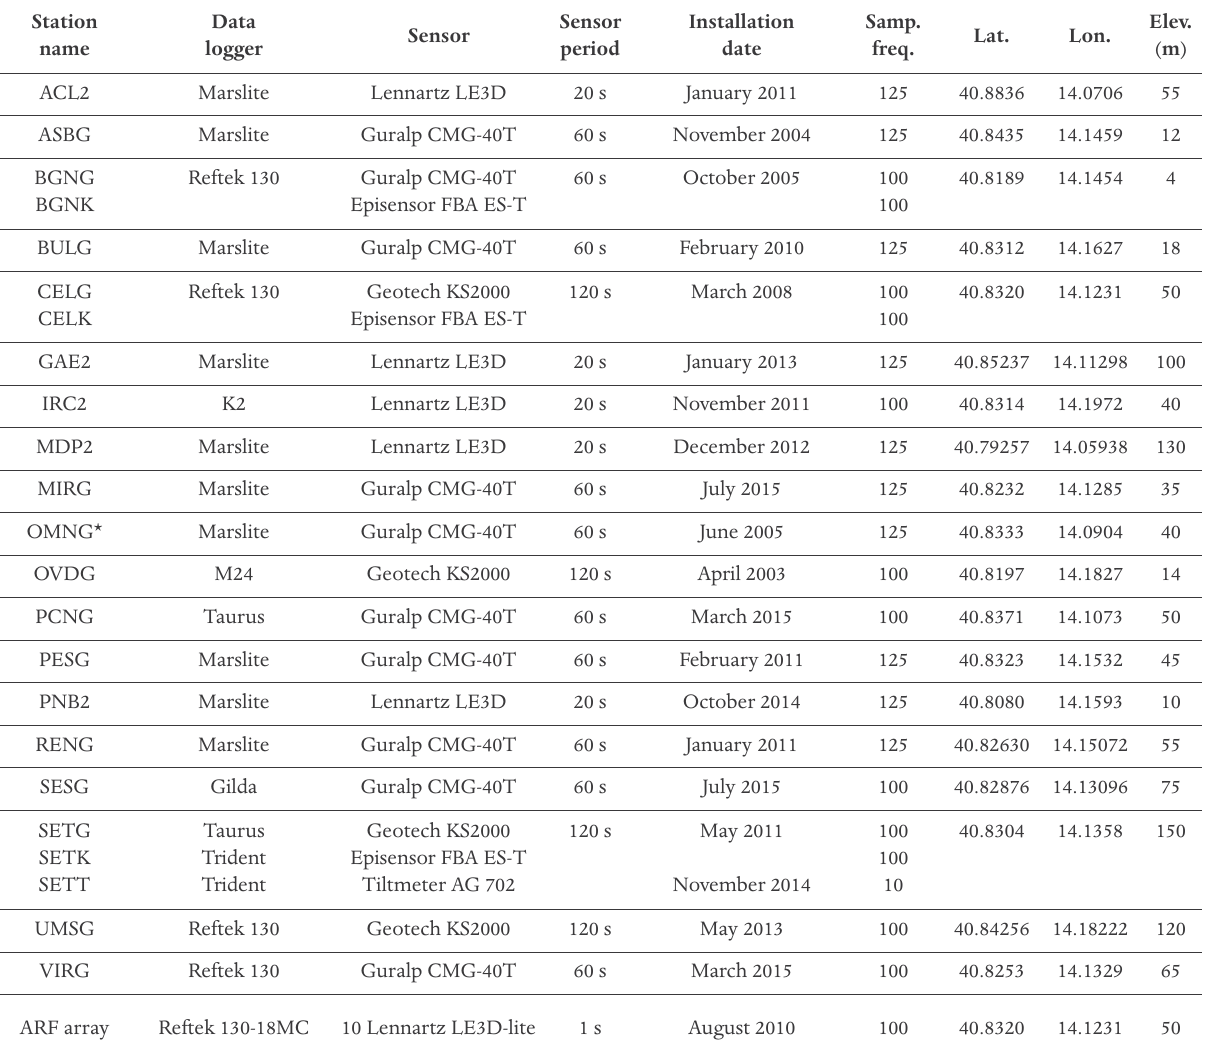
Table 1. Campi Flegrei stand-alone seismic network (August 2015). Notes: (*) OMNG was uninstalled on March 2015 because replaced by a real time station